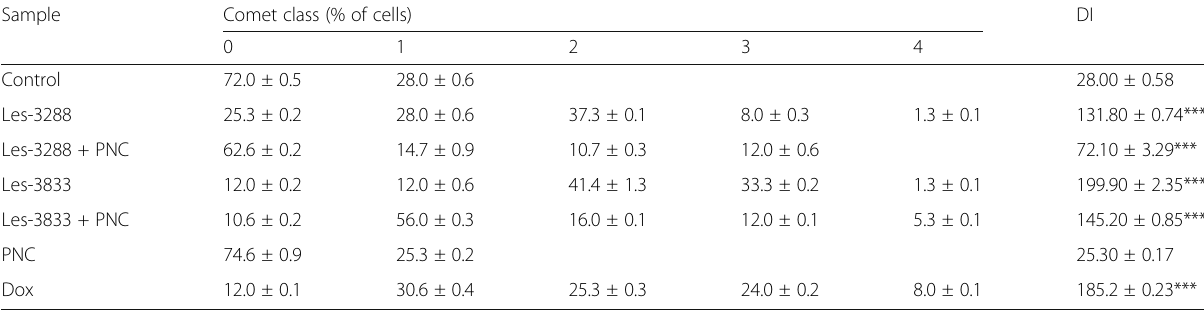
Table 3 The percentages of rat glioma C6 cells for each level of genotoxicity after 6 h of treatment with the free form of compounds Les-3288 and Les-3833, and their complexes with the polymeric nanocarrier (PNC)